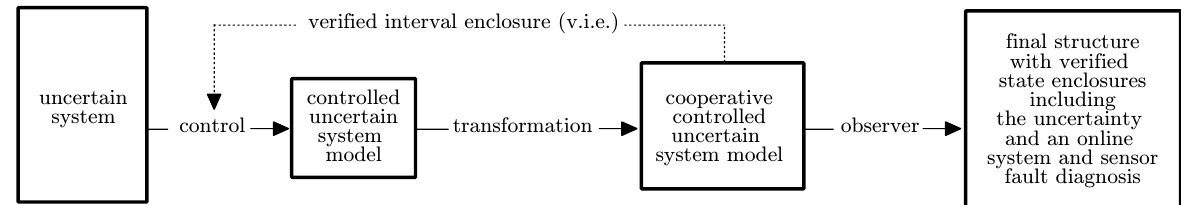
Figure 1. Outline of the presented method.